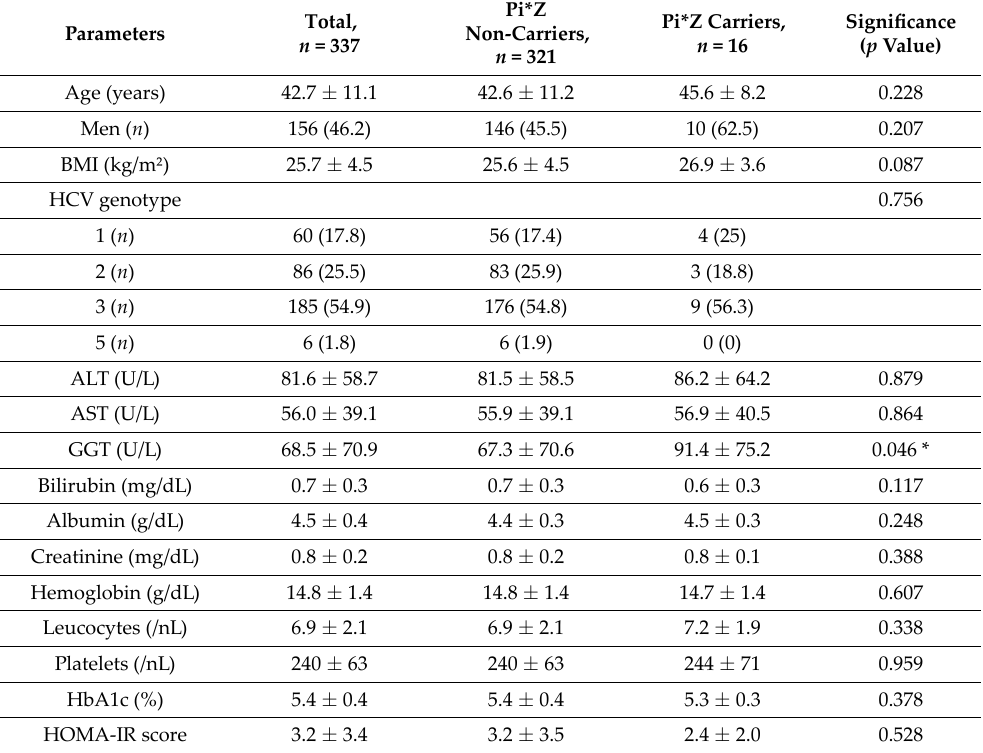
Table 1. Patients’ characteristics in the Frankfurt cohort.